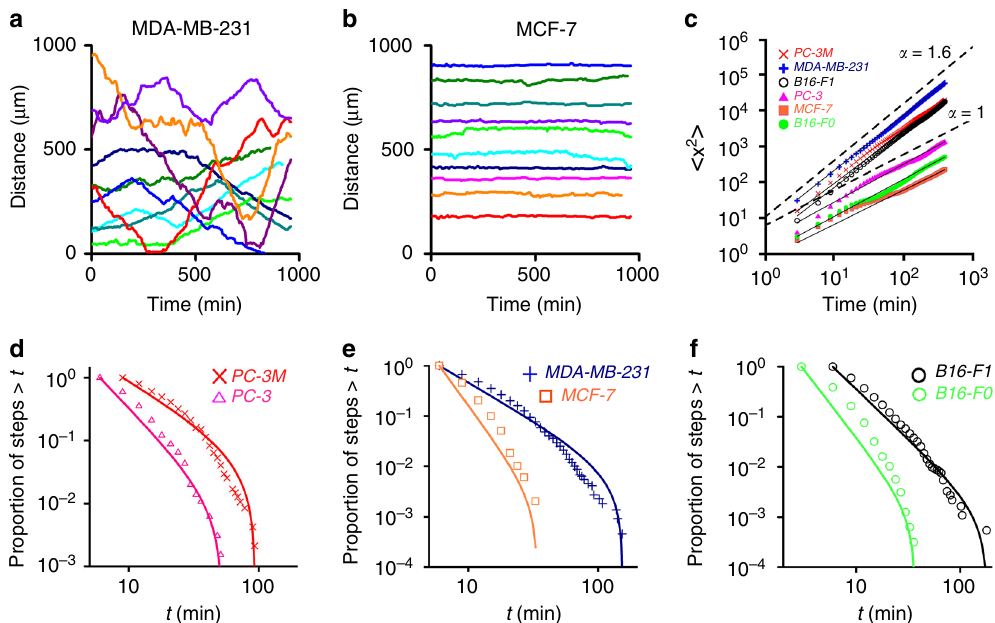
Fig. 2 Superdiffusive and Lévy walks of metastatic cancer cells on linear microtracks. a Typical trajectories/displacement versus time of highly metastatic cells (here for MDA-MB-231) feature characteristic small steps interspersed with unidirectional, long excursions. b In contrast, trajectories of non- metastatic cells (here for MCF-7) are more random/ ” jiggly ” . Ten representative trajectories per cell type are shown. The starting points for trajectories are randomly positioned along the y axis ( “ Distance ” ) for clarity. See also Supplementary Movies 1 – 6 and 13 – 15 and Supplementary Figure 1 for trajectories for PC-3, PC-3M, B16-F0, and B16-F1 cells and Supplementary Figure 2 for long-term trajectories. c Differences in the two modes of motility are quanti fi ed in (cid:1) (cid:3) / t α . The values of α close to unity (PC-3: α = 1.04, 95% con fi dence the log – log plots of the cells ’ mean square displacement (in μ m 2 ) versus time, x 2 interval ± 0.03; MCF-7: α = 0.96 ± 0.04; B16F0: α = 1.05 ± 0.02) indicate diffusive walks of non-metastatic cells. Metastatic cells are superdiffusive (PC- 3M: α = 1.58 ± 0.02; MD-MB-231: α = 1.54 ± 0.01; B16F1: α = 1.52 ± 0.02). d – f The cumulative frequency distributions, CFDs, of persistence times ( t ) for all types of cells studied on microtracks. Markers are experimental statistics: magneta triangles for PC-3, red crosses for PC-3M, blue crosses for MDA-MB- 231, orange rectangles for MCF-7, green circles for B16-F0, and black circles for B16-F1. Solid lines are theoretical truncated power law fi ts. Statistical analysis of cancer cell movements on 1D microtracks is shown in Table